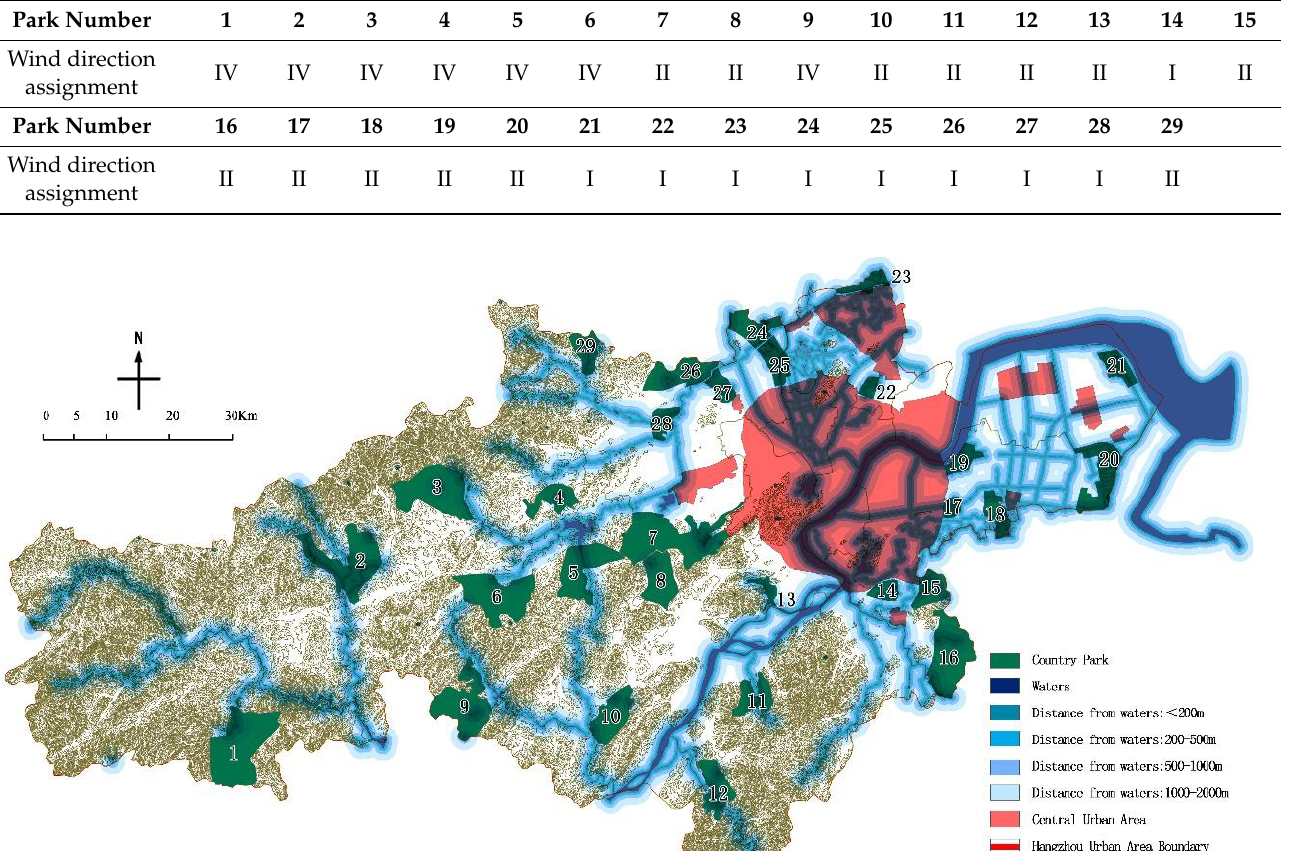
Table 12. The results of wind direction assignment of country parks.